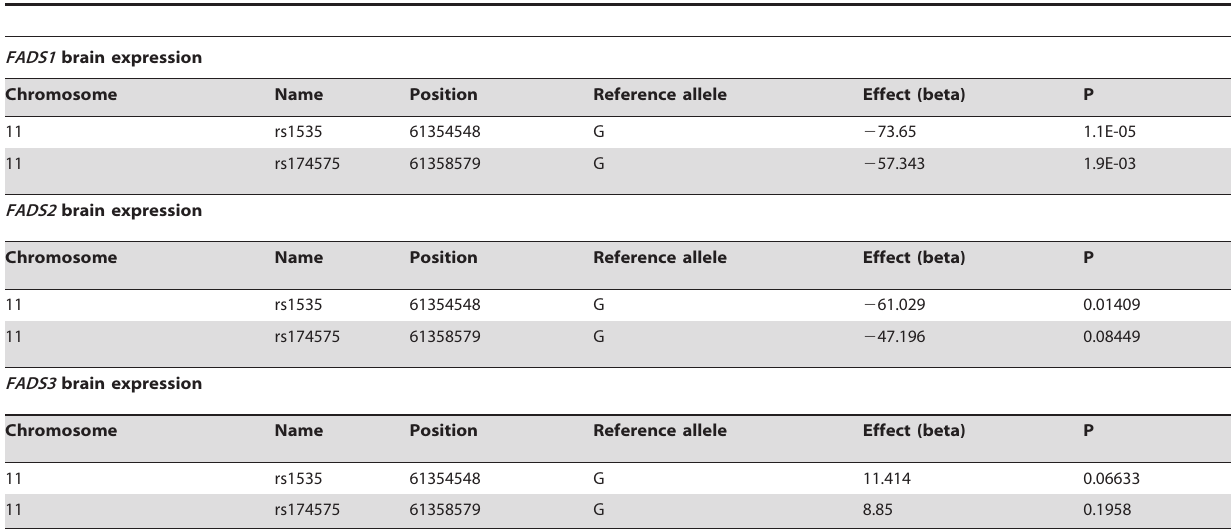
Table 2. Association of the candidate variants, previous implicated in intelligence, with the human brain expression of FADS1 , FADS2 and FADS3.